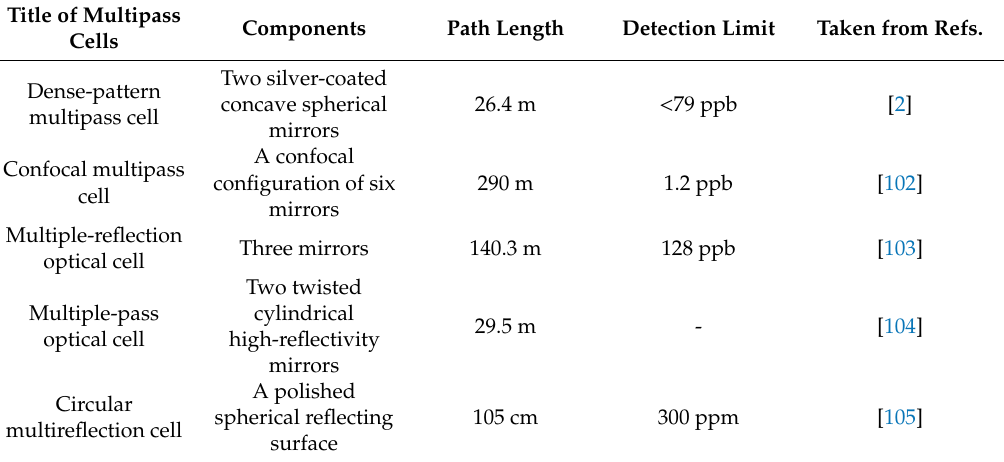
Table 1. Some parameters of novel multipass